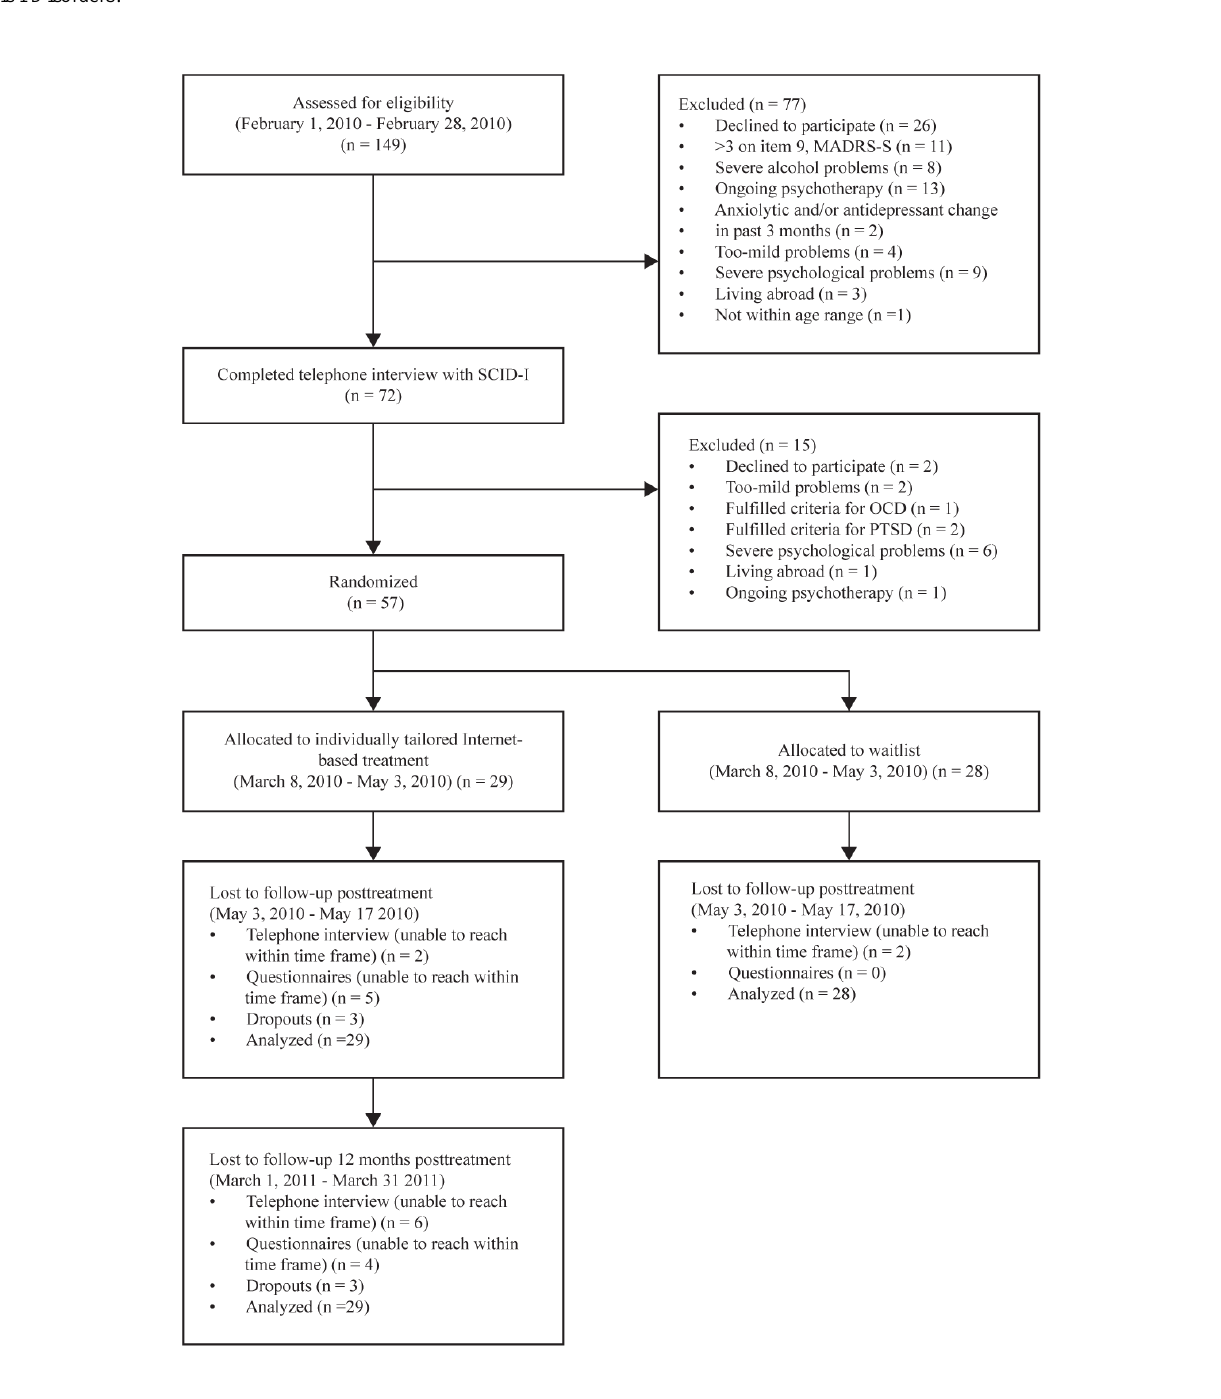
Figure 1. Flowchart of study participants, point of random allocation, and dropouts at each stage of the trial. MADRS-S = Montgomery-Åsberg Depression Scale; OCD = obsessive–compulsive disorder; PTSD = posttraumatic stress disorder; SCID-I = Structured Clinical Interview for DSM-IV Axis I